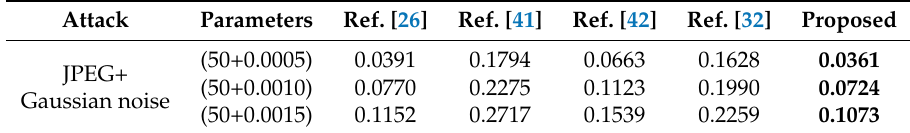
Table 6. The average BER comparison with PSNR = 42 dB under combined